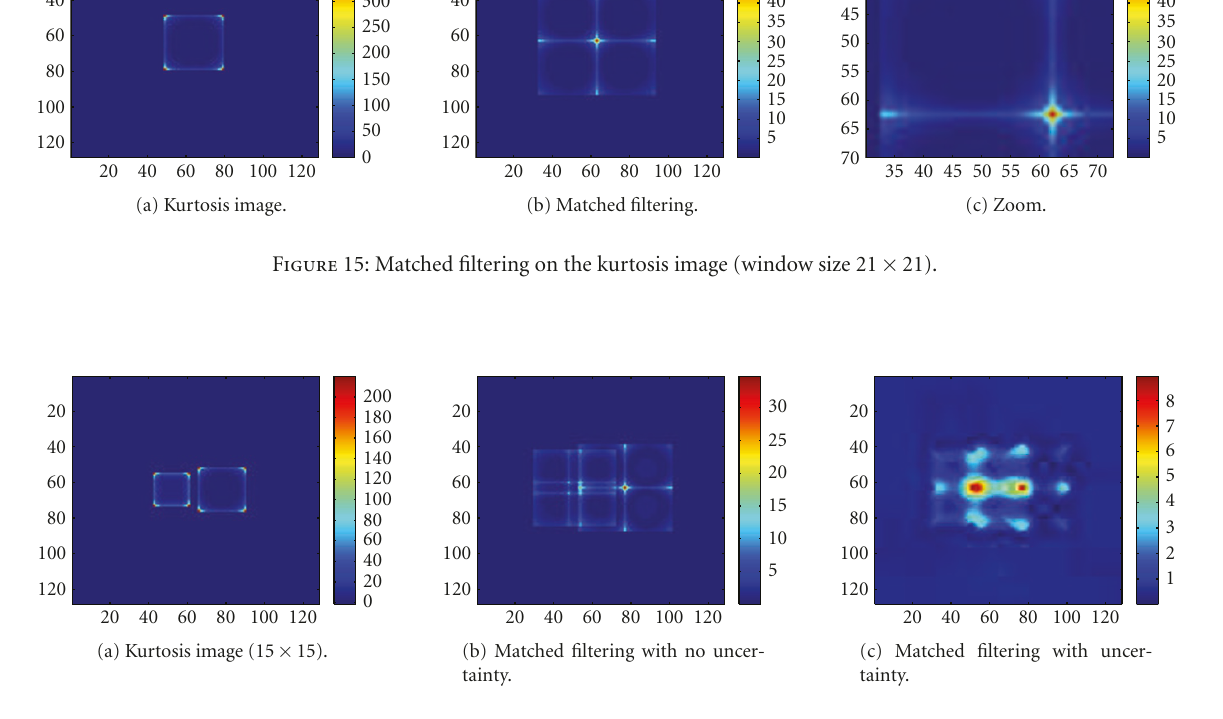
Figure 16: Matched filtering on the kurtosis image of two deterministic regions with no uncertainty (25 × 25) and an uncertainty (23 × 23, SD = 3).